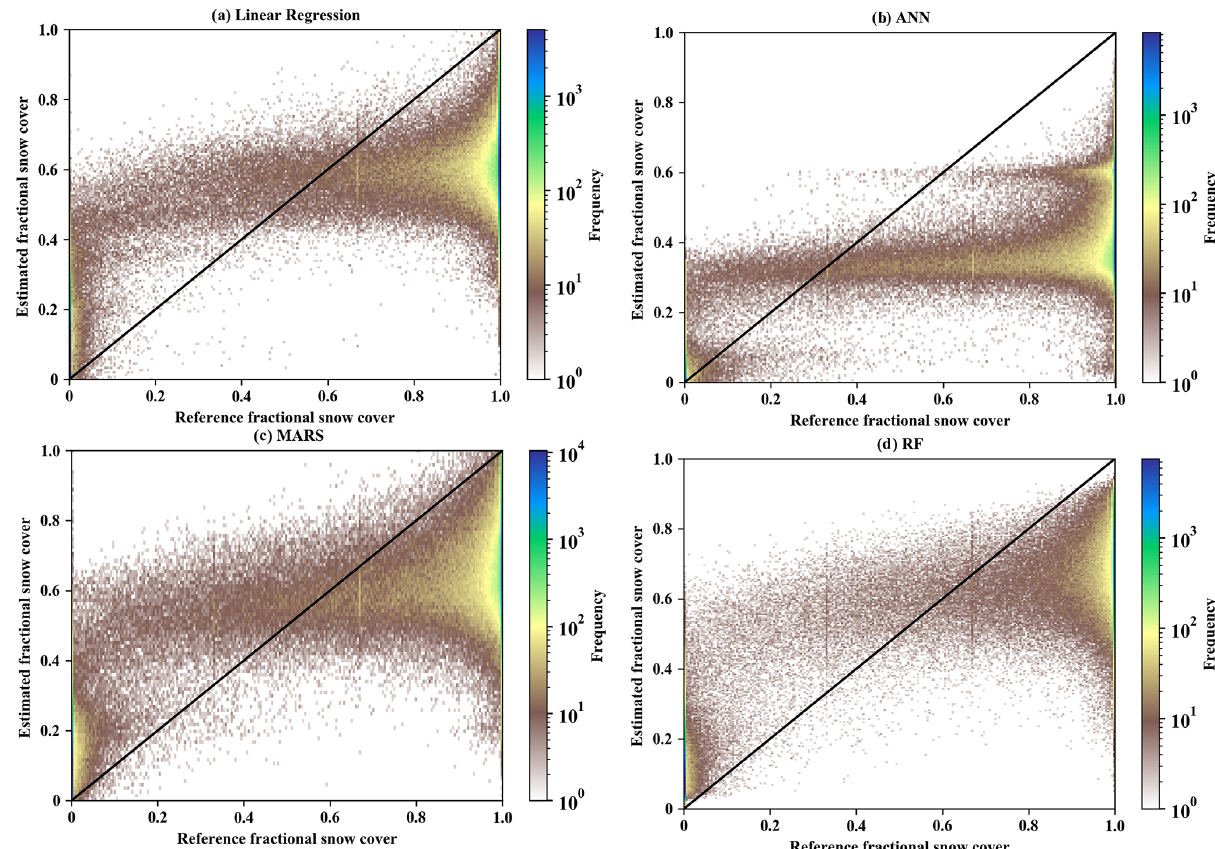
Figure 6. The color density scatter plots between the estimated fractional snow cover and MODIS-derived fractional snow cover for four algorithms (linear regression, ANN, MARS, and random forest) for forest type. The accuracy metric refers to Table 5. (Note: out-of-range fractional snow cover values of linear regression, ANN, and MARS were truncated on 0 and 1). Note that all extracted records in January and February 2010 were used as the testing